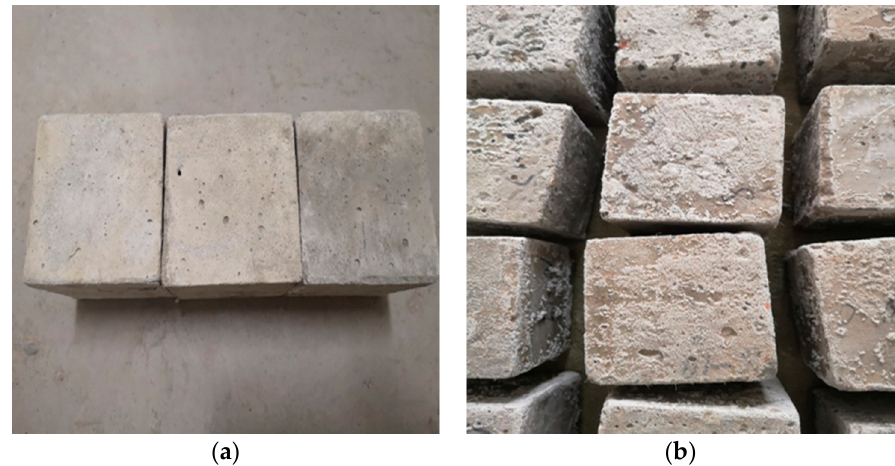
Figure 1. Nano-TiO 2 modified concrete specimen. ( a ) Specimen at room temperature. ( b ) Specimen after dry–wet cycle.